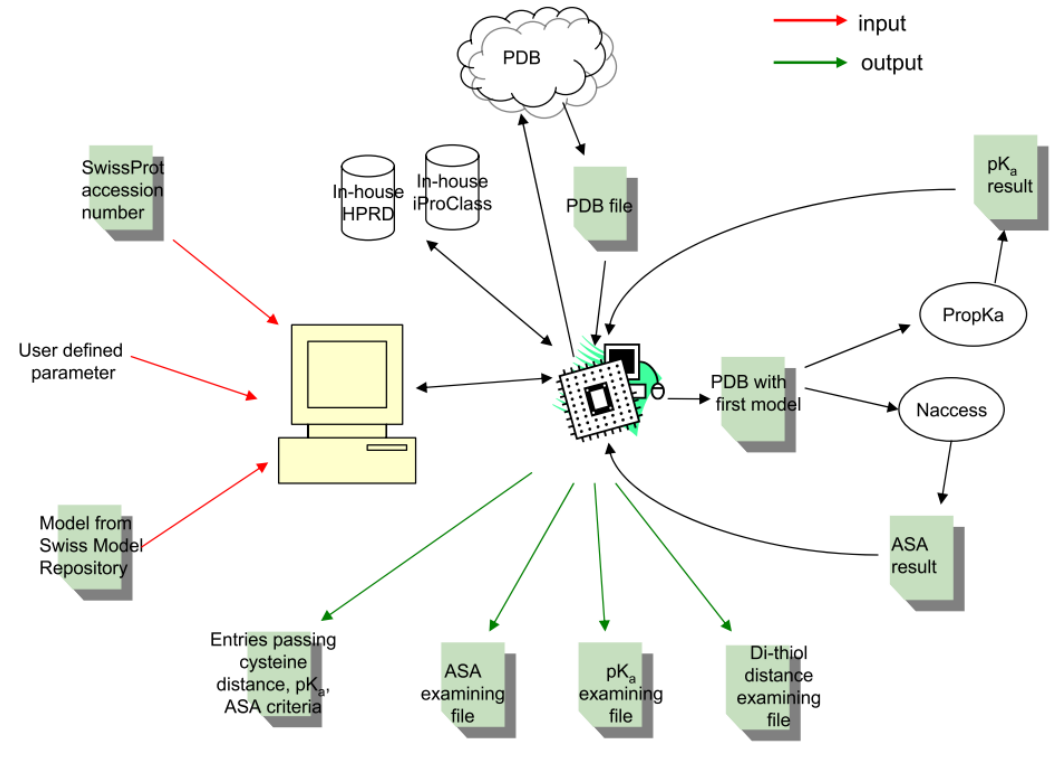
Fig. 3: The architecture of ROCD. Users are requested to provide three types of information to ROCD. ROCD utilizes three public databases (HPRD, iProClass, PDB) and two external tools (PropKa, Naccess) for the selection of reversibly oxidized cysteinyl